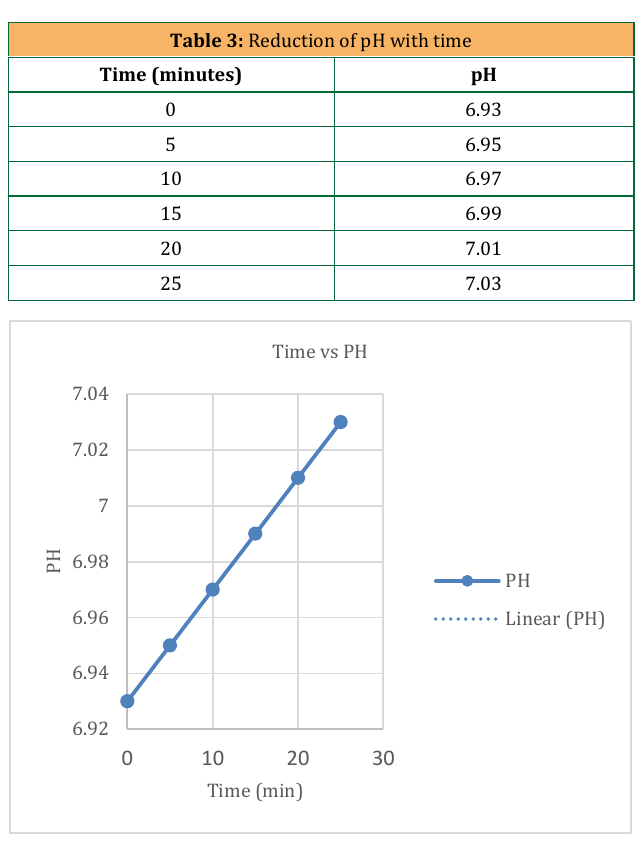
Figure 4: Graph between time and